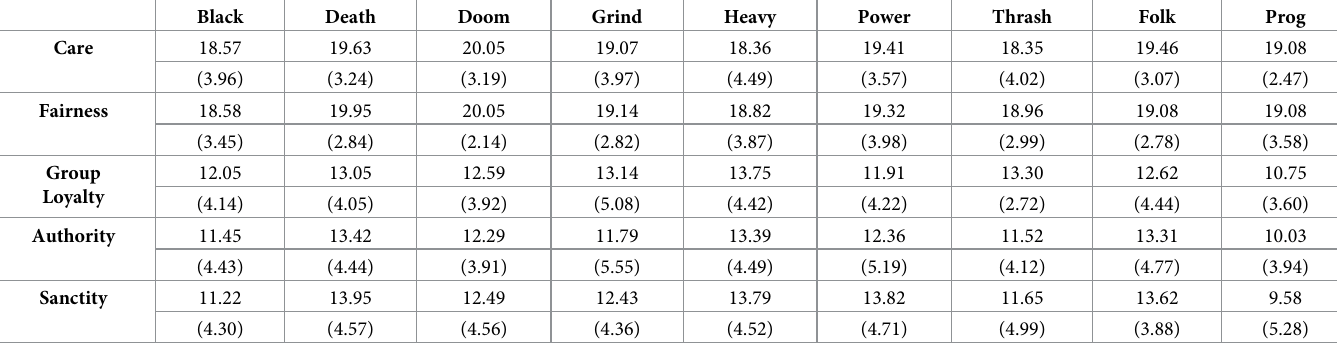
Table 4. Mean scores and standard deviations of nine types of metal fans across five moral domains.